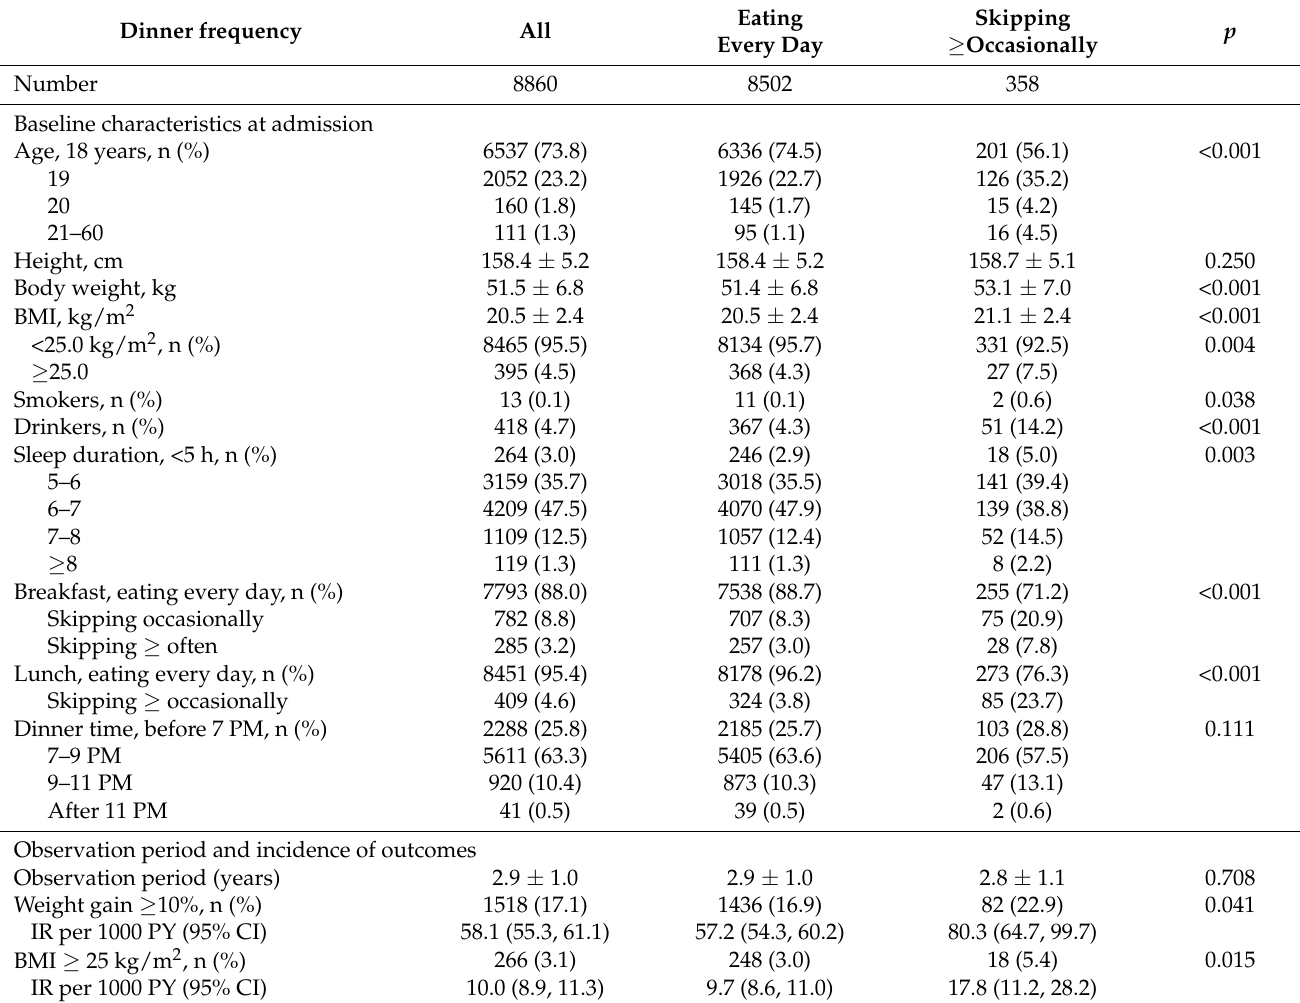
Table 2. Baseline characteristics, observation period, and outcome incidences of 8860 female students stratified by din- ner